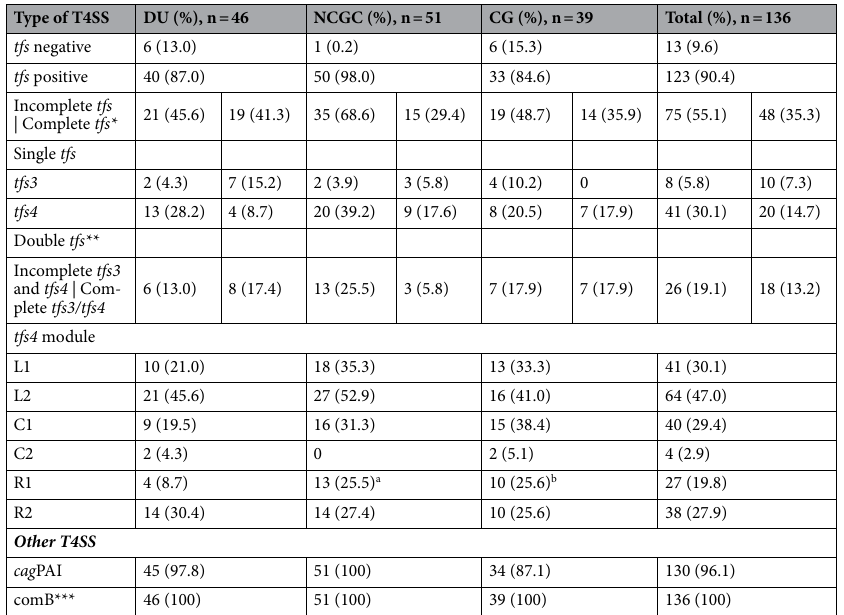
Table 1. Distribution of tfs3 and tfs4 ICE in DU, NCGC, and CG patients. 80% < Identity of gene only counted. Complete tfs harbored 11 vir genes (virB2, virB3, virB4, virB6, virB7, virB8, virB9, virB10, virB11, virD4, and virD2) ** Double tfs were divided into: both of complete tfs, one of complete tfs, and both of tfs incomplete form cagPAI harbored all ten vir genes ( virB2, virB3, virB4, virB6, virB7, virB8, virB9, virB10, virB11, and virD4 ). *** comB harbored all seven vir genes ( virB2, virB3, virB4, virB7, virB8, virB9, and virB10 ). a Indicated the significant different between NCGC to DU at P < 0.05. b Indicated the significant different between CG to DU at P < 0.05.